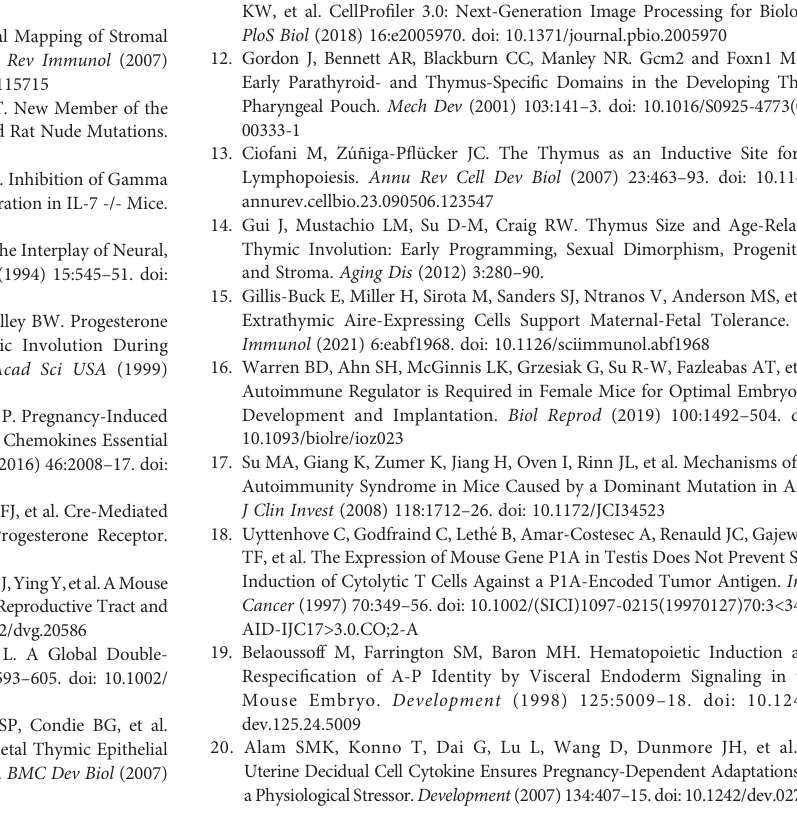
Supplementary Figure 2 | Representative immuno fl urescence images taken at 200x magni fi cation of the thymus used to calculate percentages represented in Figure 2B . Scale bar = 100um. Supplementary Figure 3 | Thymus was excised and sectioned at 5 m m from Pgr WT ;Rosa mTmG/mTmG female at GD14.5 to demonstrate that Pgr Cre activity in the Rosa mTmG/mTmG reporter females during pregnancy is speci fi c. Scale bar = 2000 m m. Magni fi cation = 100x. Supplementary Figure 4 | (A) Serum progesterone (P4, Left) and estradiol (E2, Right) levels in non-pregnant (NP) and GD16.5 dams from control C57BL/6 females compared to Pgr f/+ and Pgr f/f (FLWT/FLFL) and Pgr d/d (FLKO) females. n=3 for all conditions and genotype. Statistical analysis were performed using student ’ s t-test between NP and GD16.5 for each genotype. *p< 0.05; **p < 0.01, ***p<0.001, ns = non signi fi cant. (B) GD16.5 thymus of Pgr d/d (left) and Pgr f/f (right) dual stained with anti-cytokeratin 5 (K5) and anti-cytokeratin 8 (K8) to characterize medullary islands (K5) in the fi eld of cortex (K8). Supplementary Figure 5 | (A) Thymus weight in C57BL6WT, Pgr f/+ and Pgr f/f (FLWT/FLFL) or Pgr d/d (FLKO). (B) Number of cells in the thymus of C57BL6WT, Pgr f/+ and Pgr f/f (FLWT/FLFL) or Pgr d/d (FLKO) thymus. Statistical analysis was performed using non-parametric Kruskal-Wallis test with post doc Dunn test. P- values adjusted using Bonferroni method. *p<0.05, **p<0.01, ****p<0.00005, ns = non signi fi cant. Supplementary Figure 6 | Assessment of short-term fertility outcome in Pgr f/f or Pgr f/+ and Pgr d/d in syngeneic mating strategy. (A) Size of the litter born from each genotype mated with C57BL6/J males for syngeneic mating. Each point represents a dam. (B) Average weight of pups at GD16.5 in each genotype. Each point represents a dam. (C) Calculation of % resorbed fetus at GD16.5 by comparing number of live pups to resorbed sites in each